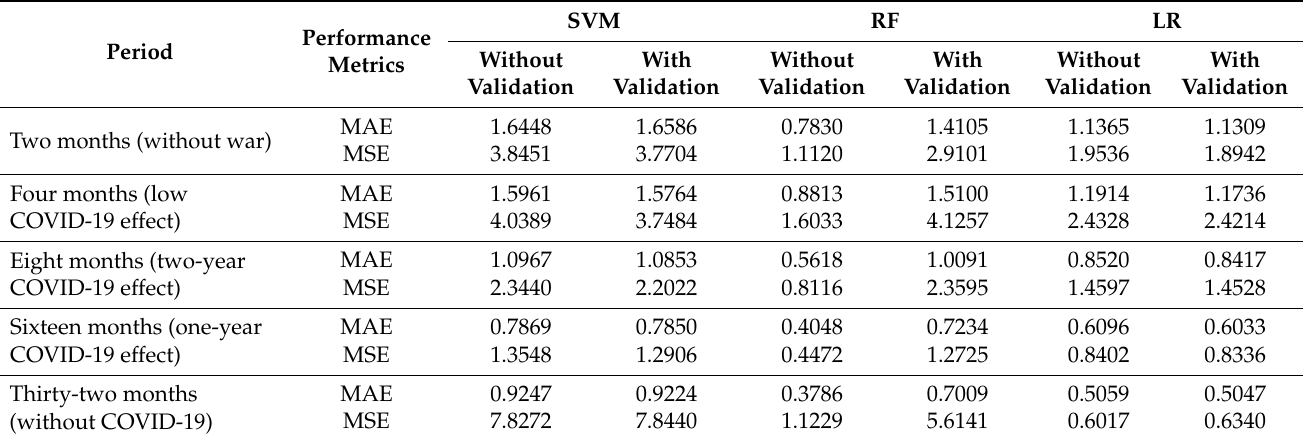
Table 3. Performance results using machine learning.